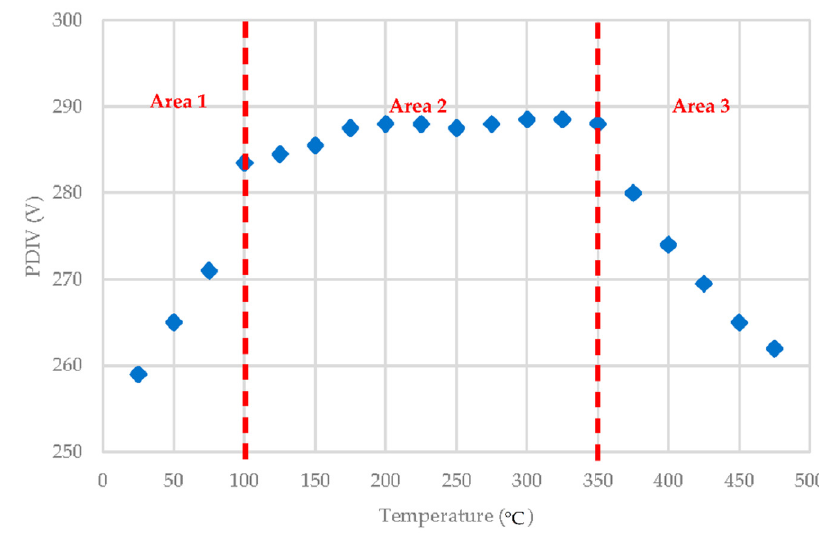
Figure 5. Temperature dependence of the discharge inception voltage (PDIV).